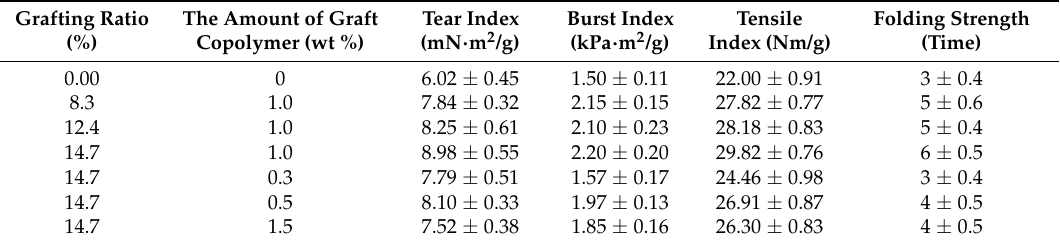
Table 3. Influence of xylan-g-PAM with different grafting ratios and different amount on the mechanical properties of